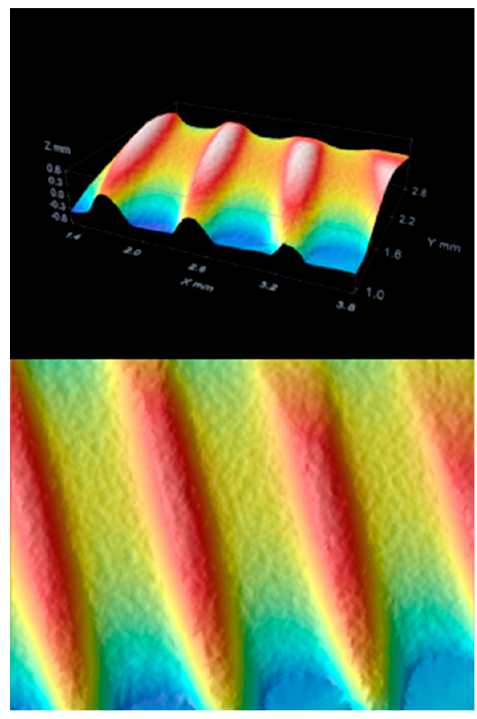
Figure 5. Test group confocal microscopy.